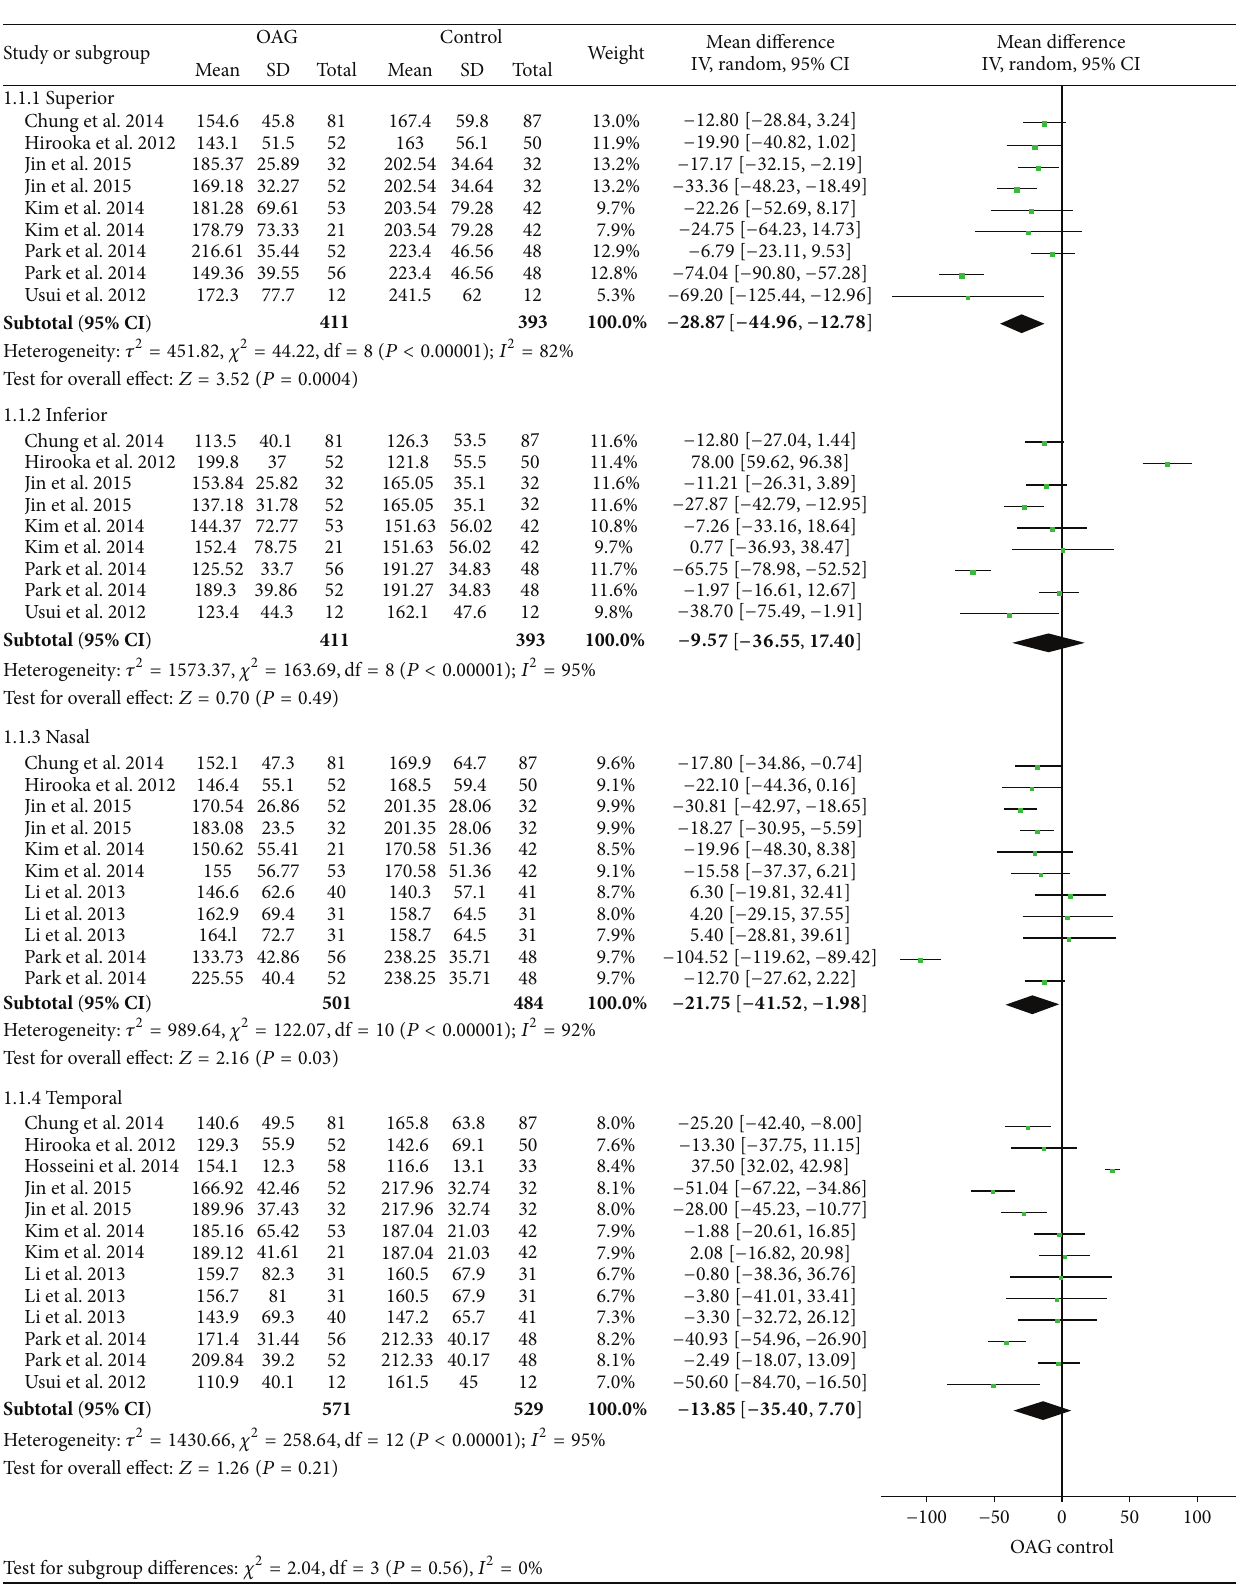
Figure 3: Forest plots of PPCT in each quadrant between open-angle glaucoma patients and